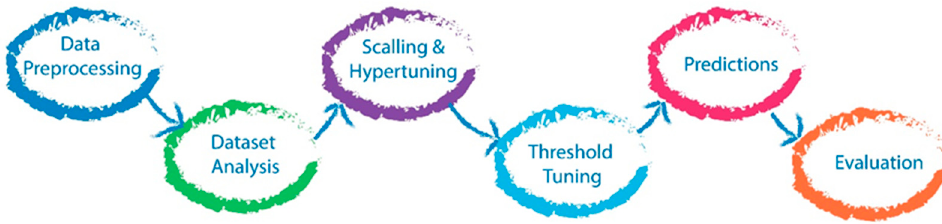
Figure 1. Data analysis workflow.